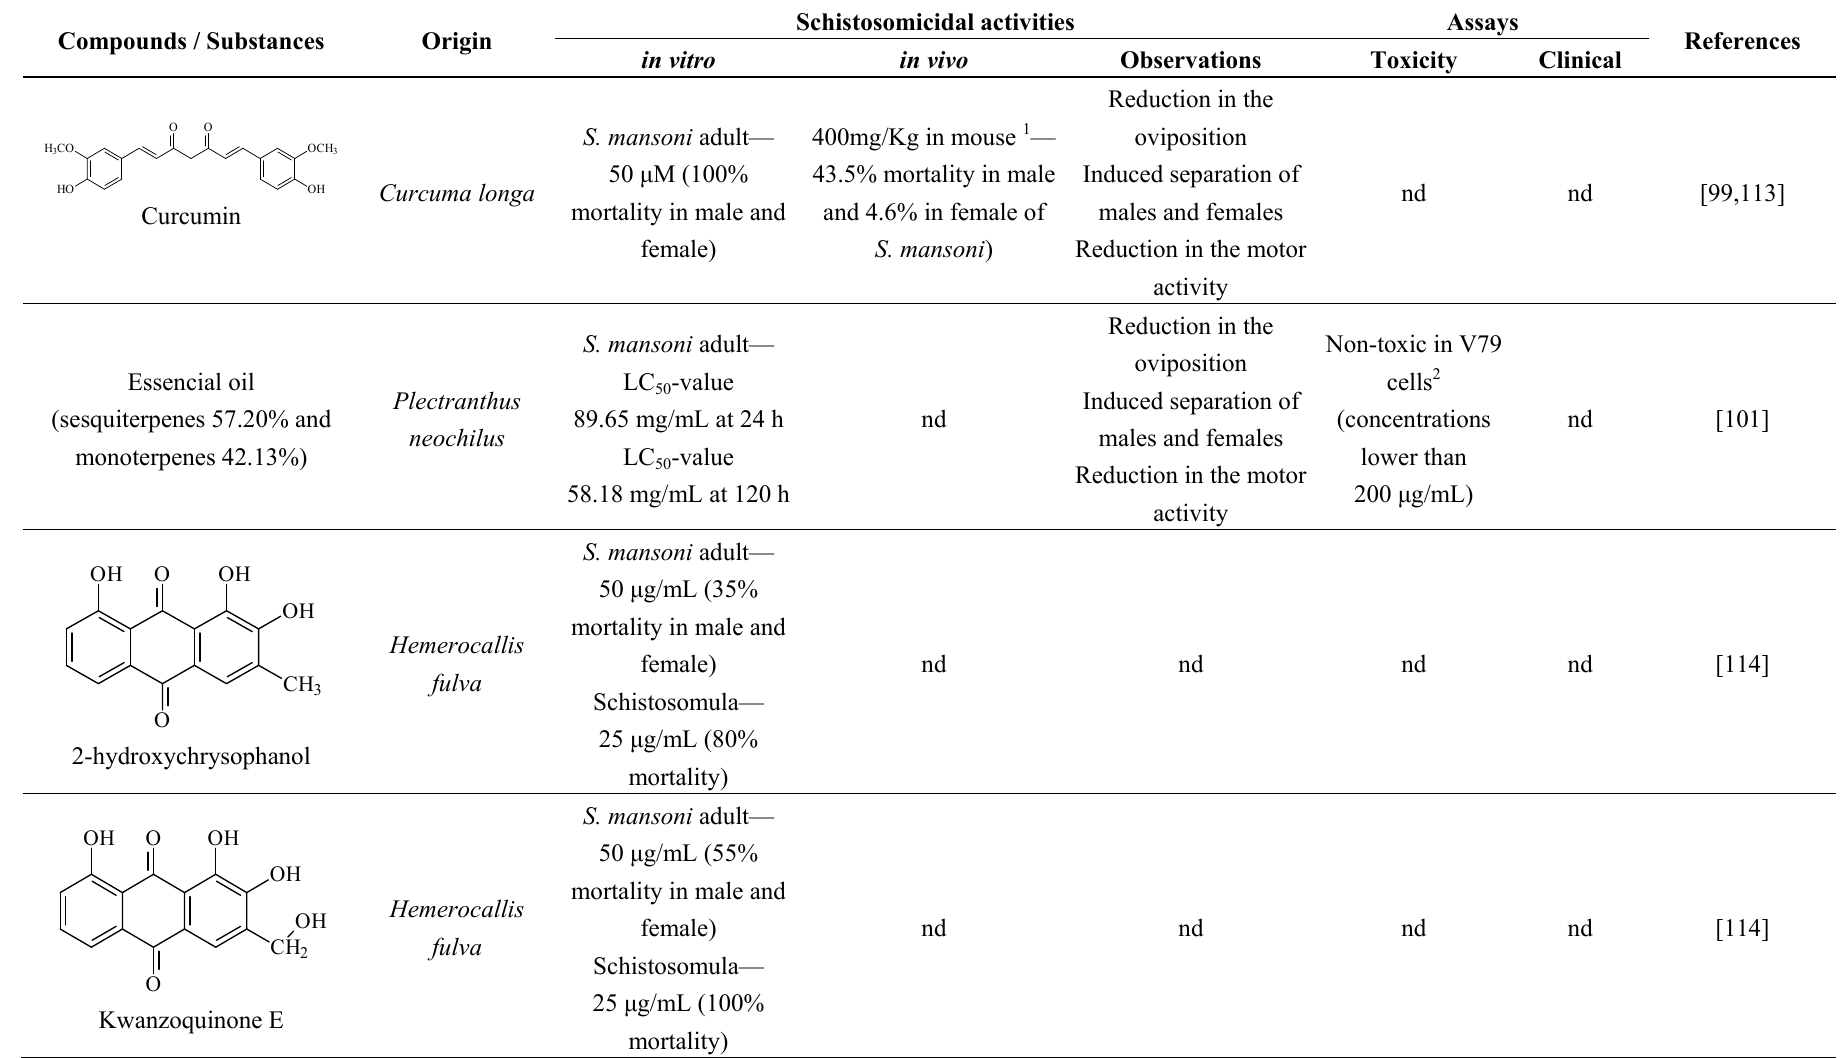
Table 2. List of medicinal plants, products and active compounds known to have anti-schistosomal properties. Compounds /